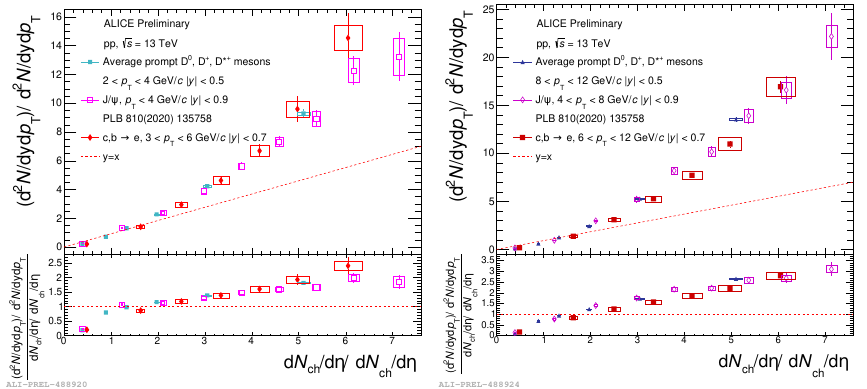
Figure 3: Average D-meson, J / ψ [ 6 ] , and heavy-flavor hadron decay electrons self- normalized yields as a function of charged-particle multiplicity at midrapidity in pp (cid:112) s = 13 TeV at compatible low (left) and high (right) p collisions at bottom panels show the comparison of double ratios between the species.